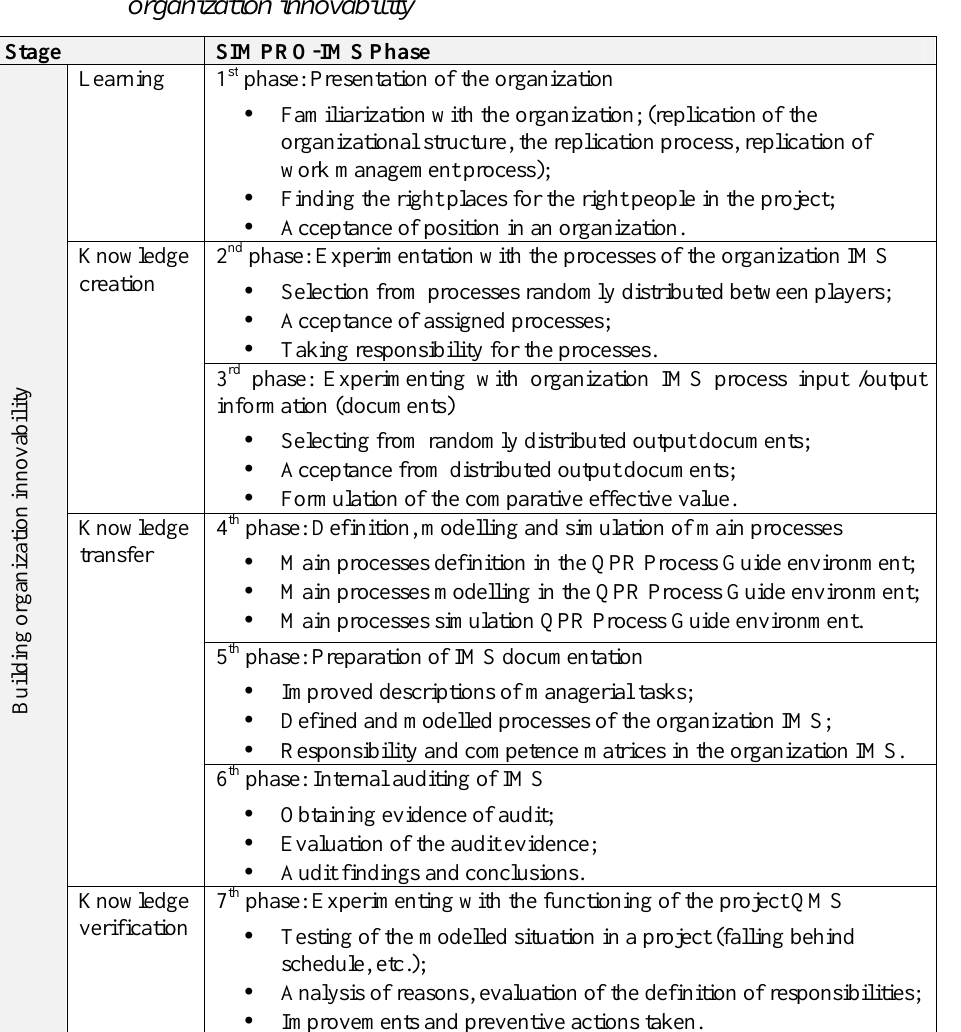
Table 2 – SIMPRO-IMS phases and learning stages for building